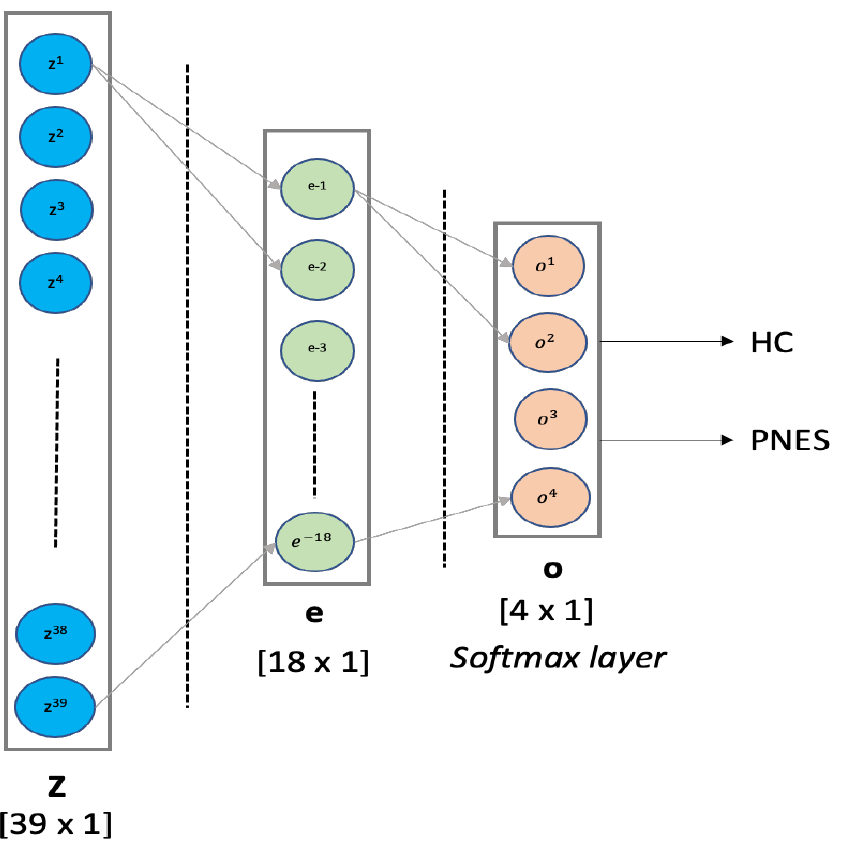
Figure 2. MLP architecture. Our MLP architecture comprises one hidden layer with 18 units, followed by a softmax layer, for binary